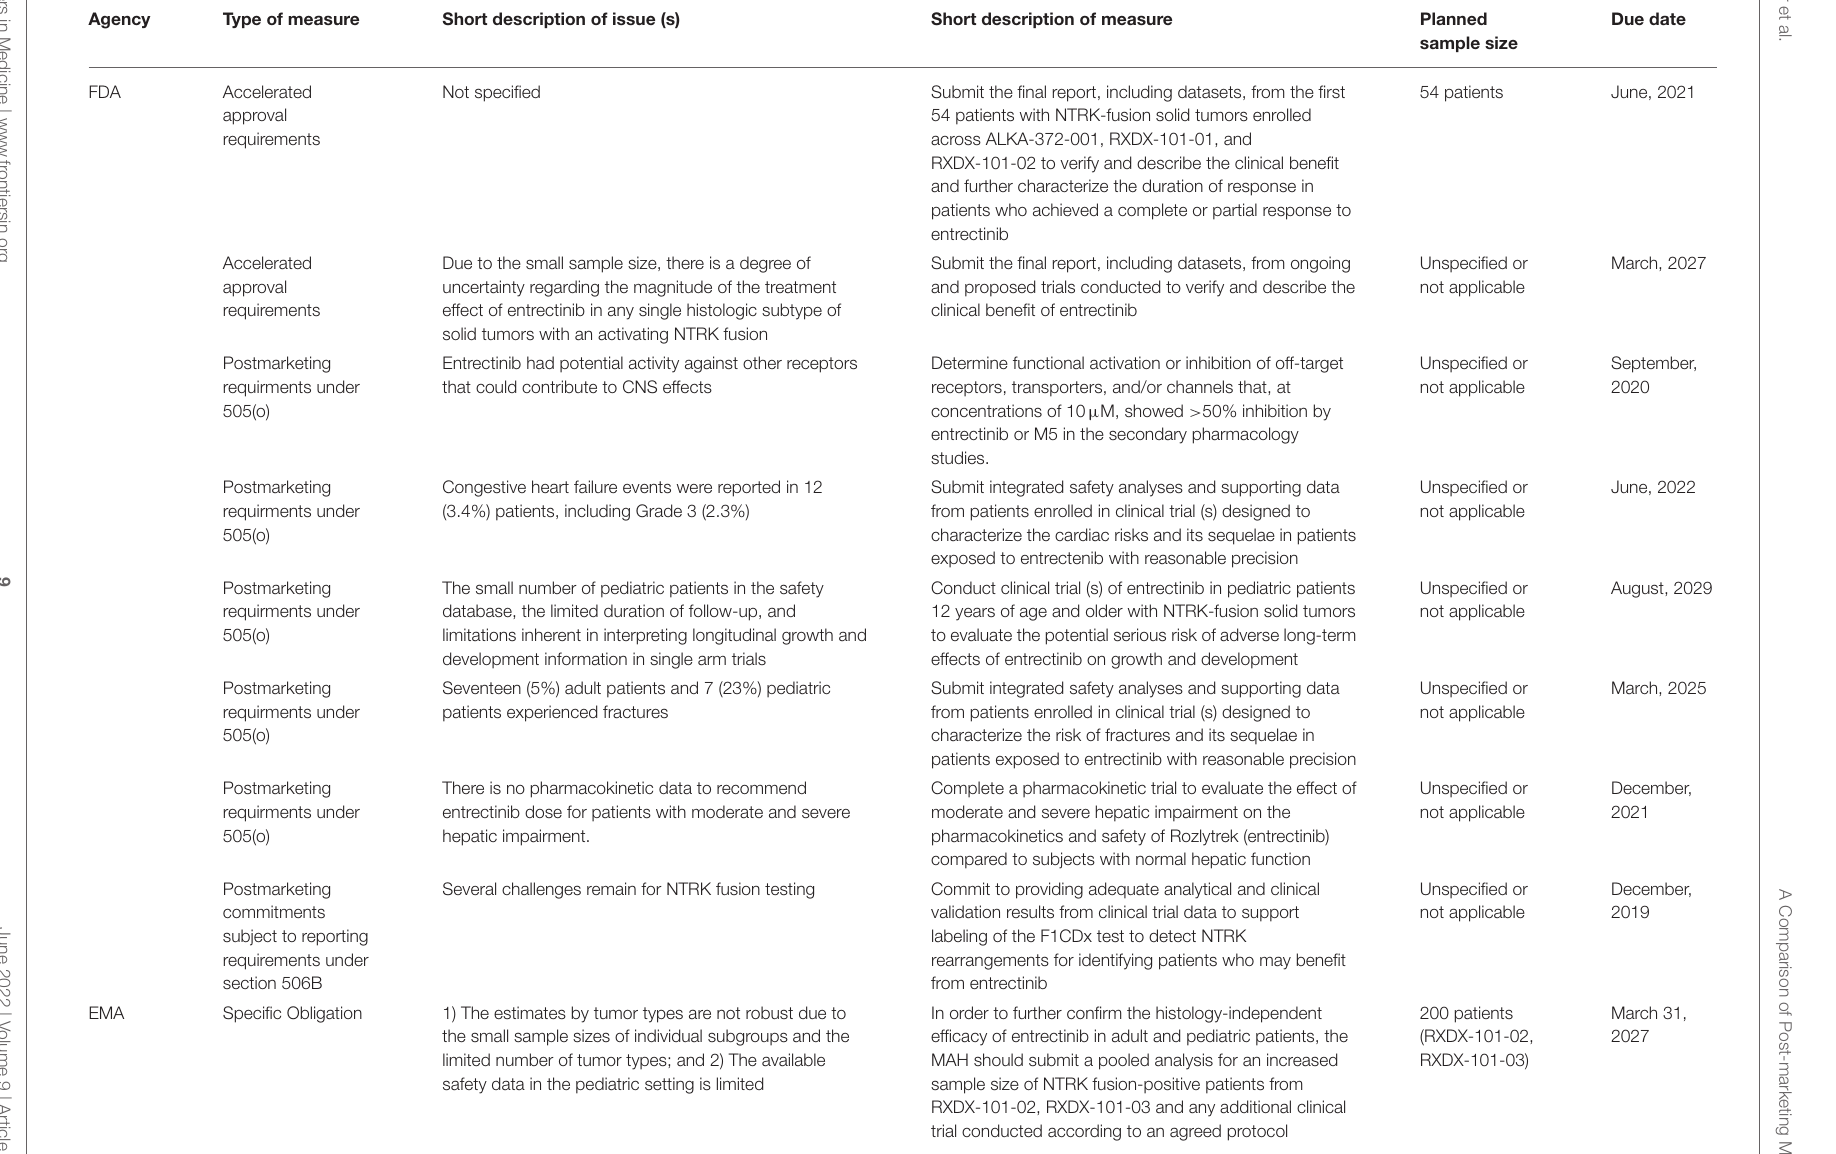
TABLE 6 | Post-marketing measures for entrectinib for the treatment of NTRK tumors.